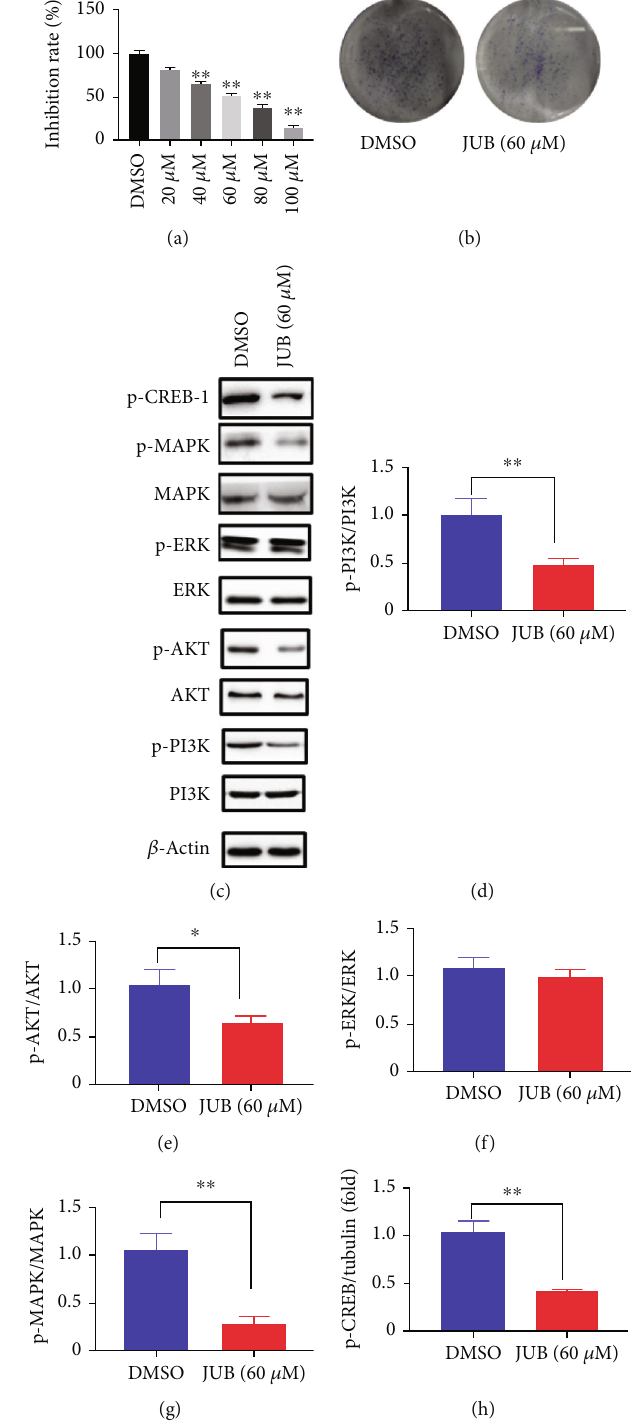
Figure 8: JUB inhibits tumor progression in A549 cells. (a) Cell growth-inhibition rate of JUB. (b) Clone formation. (c) Representative western blotting bands of A549 cells. (d – h) Statistical analysis of p-PI3K/PI3K, p-Akt/Akt and p-MAPK/MAPK, p-ERK/ERK, and p- CREB/Tubulin. Data were expressed as mean ± SD ( n = 8/group ). ∗ P < 0 : 05 and ∗∗ P < 0 : 01